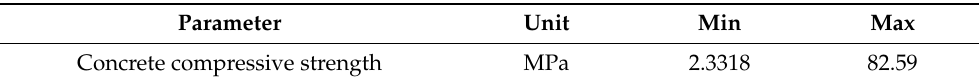
Table 2. Prediction of concrete compressive strength by artificial neural network (ANN).